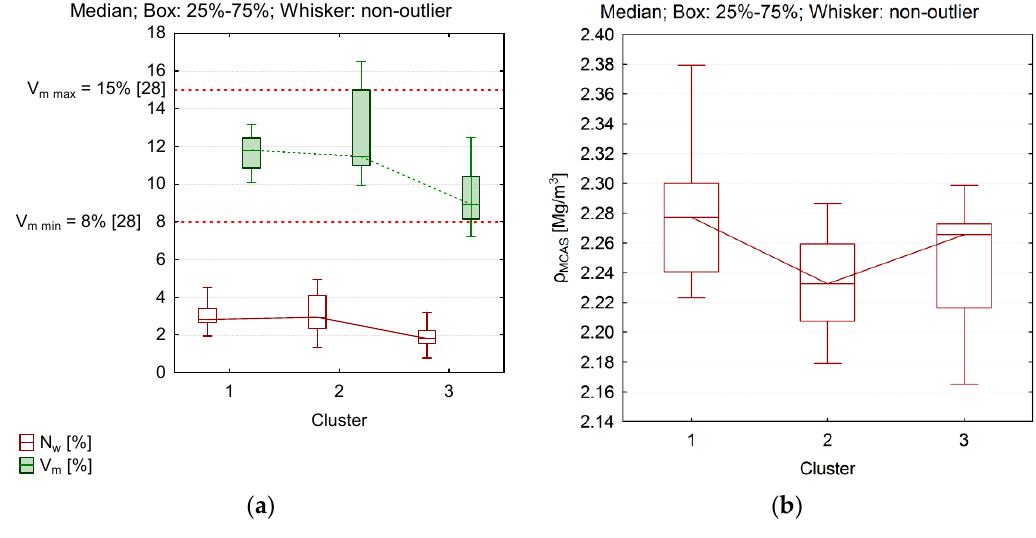
Figure 6. Grouping by ( a ) air void content (V m ), absorption (N w ); ( b ) density ( ρ MCAS ).